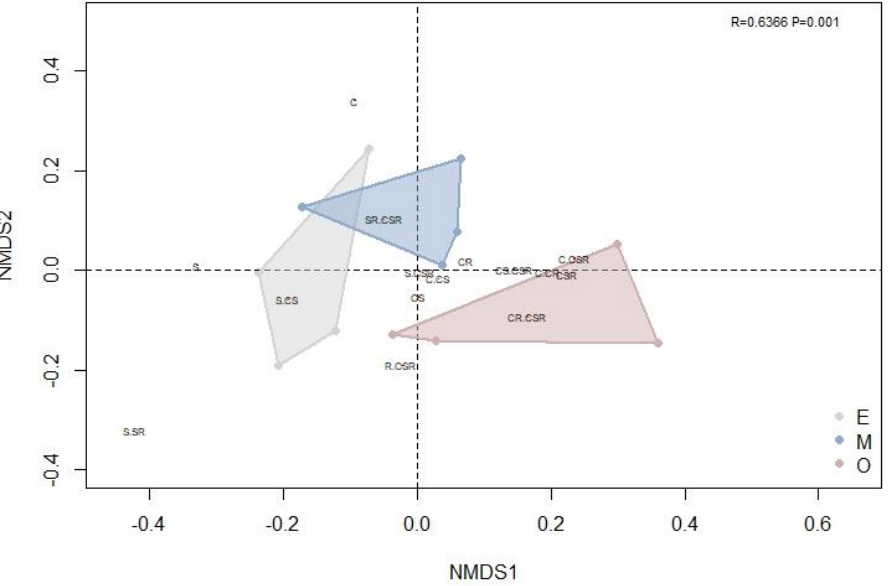
Figure 3. A non–metric multidimensional scaling (NMDS) diagram based on species richness was used to compare forest communities of different successional stages in the tropical lowland rainforest of Hainan Island. Polygons of different colors represent different successional stages (gray, E, early succession; blue, M, mid-succession; and red, O, late succession). Text labels within the plot represent ecological strategies (C = competitors, S = stress tolerators and R = ruderals); please refer to the CSR classification of Hodgson et al. (1999) [19] for a more detailed description. For the NMDS, R = 0.6366 and p = 0.001.